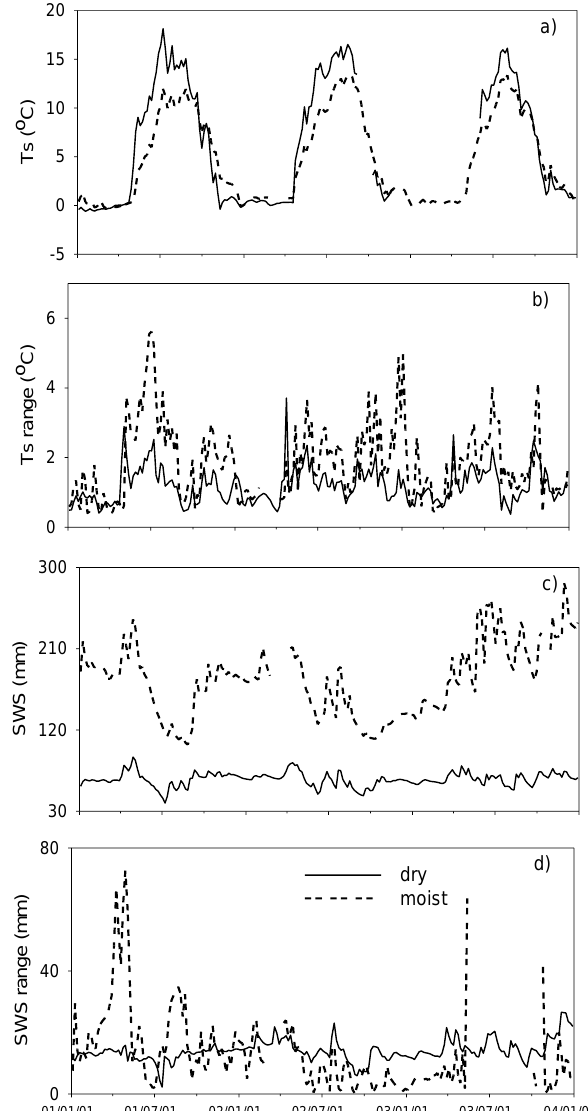
Fig. 2. (a) Observed soil temperature at 3 cm (T s ). (b) The T s variability range within the plot. (c) Observed soil water storage (0-30 cm) (SWS) and (d) the SWS variability range within the plot from dry and moist plots at Knottåsen during 2001-2003. All values are 5-day averages.